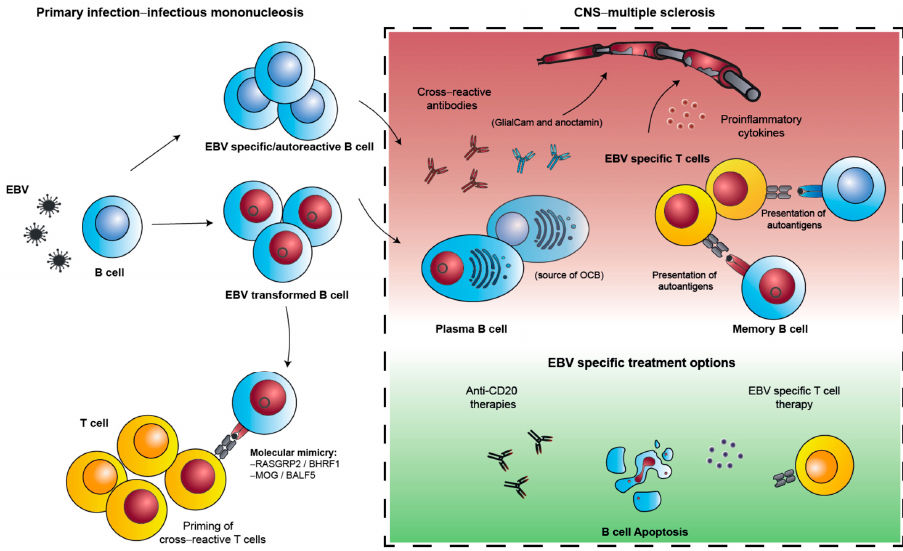
Figure 1. Potential mechanisms behind EBV’s association as a prerequisite of MS development. Strong immune activation during primary EBV infection, especially in genetically predisposed individuals could lead to insufficiently controlled EBV transformed B cells (represented as red nuclei). Those cells could allow the activation and expansion of autoreactive T cells (cross-reactivity depicted as red nuclei). Additionally, EBV infection could allow the proliferation and priming of noninfected, EBV and autoantigen specific B cells (depicted as blue nuclei). Through an unknown mechanism EBV transformed and EBV reactive B cells could home to the CNS, triggering the migration of other autoproliferative lymphocytes. In the CNS, plasma B cells producing cross- reactive antibodies against myelin antigens and memory B cells that act as APCs for the cross- reactive T cells trigger the production of proinflammatory cytokines. Together, this could start the immunopathology seen in MS as myelin damage. Treatments that either dampen the cross-reactive immune response (anti-CD20 treatment) or strengthen EBV specific immune control (EBV specific T cell therapy) might lead to the elimination EBV transformed B cells and ameliorate MS disease. Such poorly controlled EBV infected B cells could migrate to the brain, where their presence has been detected by some but not other groups [61–65]. Along these lines, EBV infected B cells could be adapted for increased brain homing in mice [66]. This adaptation led to upregulation of EBNA1, secreted phosphoprotein 1/osteopontin (SPP1/OPN), neuron navigator 3 (NAV3), CXCR4 and germinal-center-associated signaling and motility protein (GCSAM). Blocking osteopontin could significantly compromise brain homing of EBV infected B cells in this experimental model. Despite the controversy on EBV infected B cell homing to the CNS of MS patients, B cell infiltration has been detected in MS brains and especially in progressive MS disease, and B cell infiltration and follicle formation in the CNS correlate with the severity of disease progression [67,68]. A distinct activated Tbet + CXCR3 + memory B cell population has been reported to be preferentially enriched in the CNS compartments of MS patients, a phenotype found to be sustained by chronic EBV infection in mice [69,70]. To what frequency and extent EBV infected B cells are involved in the formation of these structures remains unclear but they could be involved in stimulating autoimmunity (Figure 1). Indeed, increased brain homing